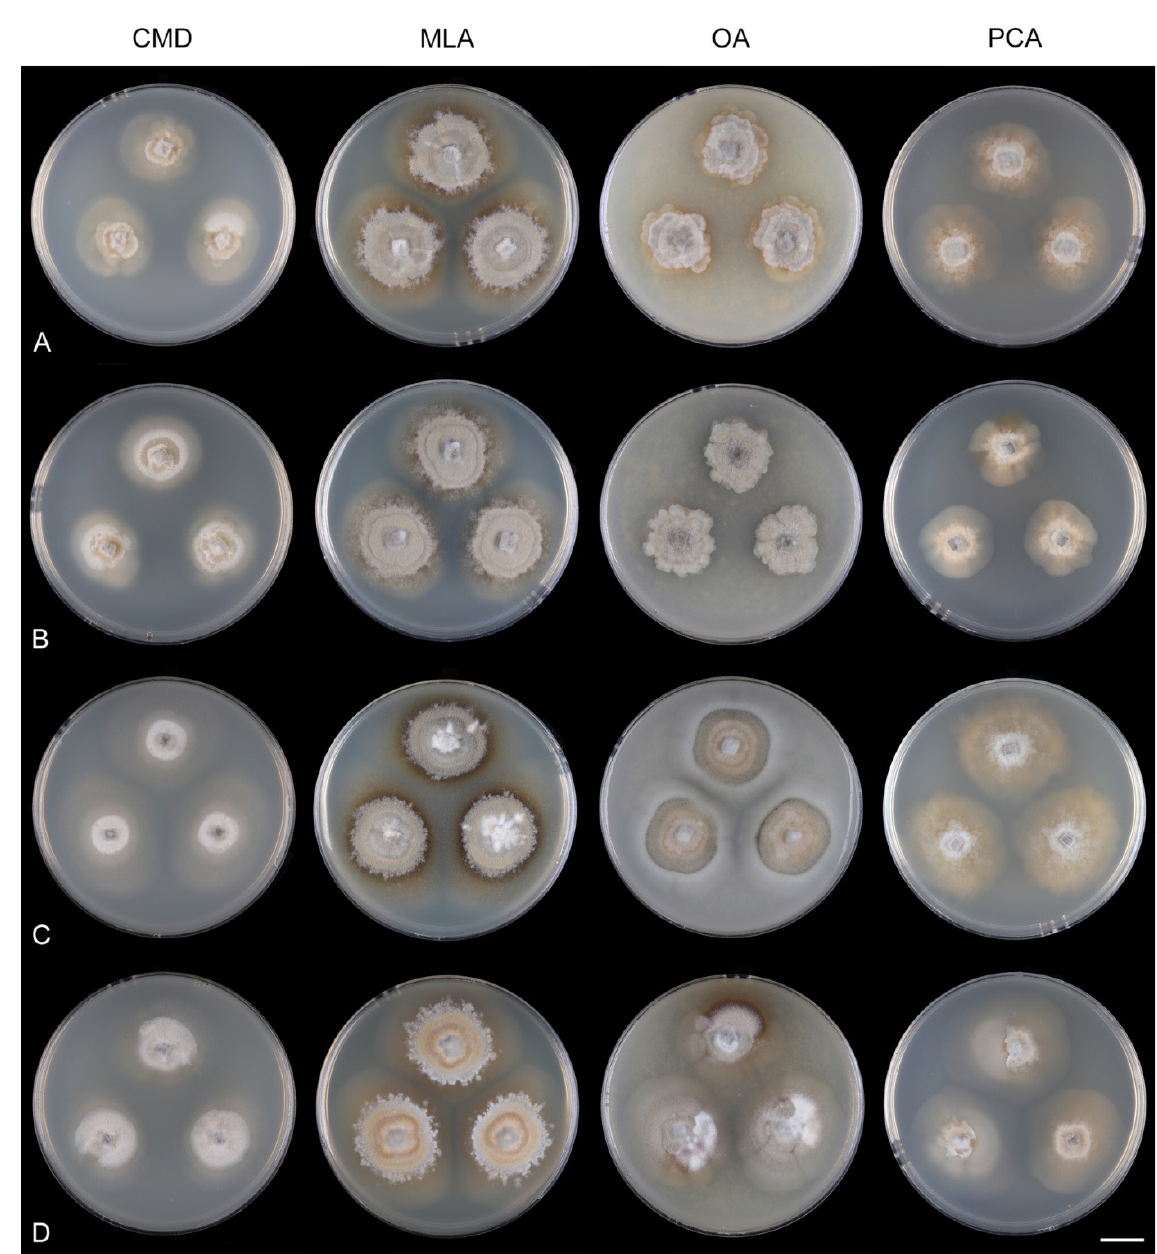
Figure 37. Colony morphology of Stilbochaeta brevisetula after 4 weeks. ( A ) ICMP 22548 ( B ) ICMP 22549 ex-epitype ( C ) ICMP 22551 ( D ) ICMP 22552. Scale bar: ( A – D ) 1 cm.